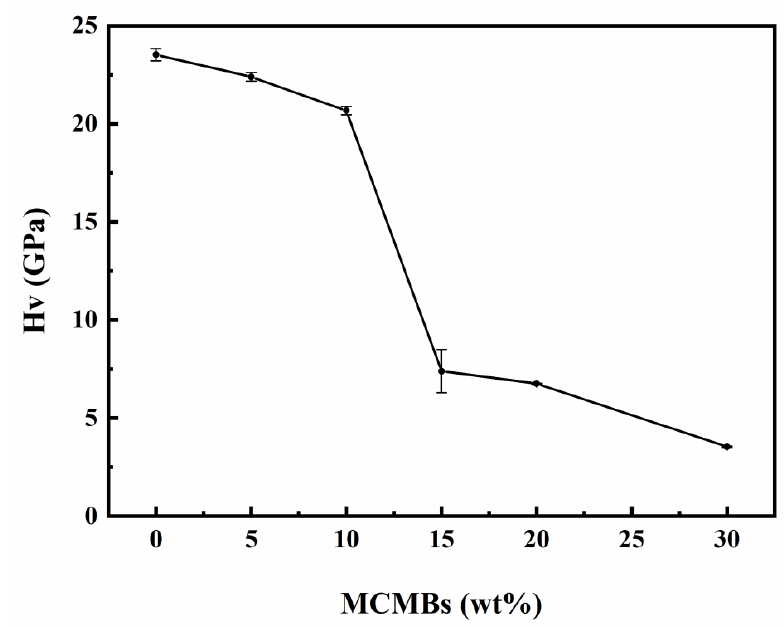
Figure 4. Relationship between MCMB content and hardness (HV).